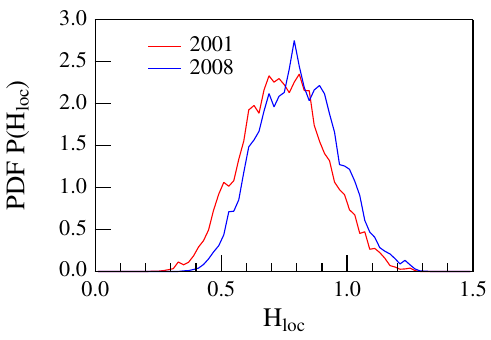
Fig. 12. The PDFs of the local Hurst exponent H loc computed for the two selected periods by means of the DMA technique.